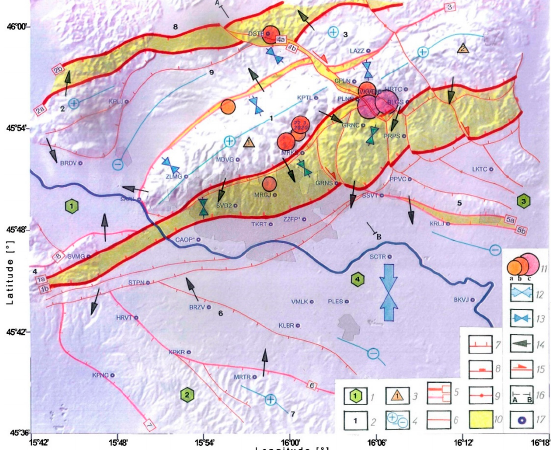
Figure 2. Recent geologic structural framework and seismotectonic activity; 1—Structural units: Žumbera č ka gora ‐ Medvednica (1), Vukomeri č ke gorice ‐ Šamarica (2), Dugo Selo ‐ Vrbovec ‐ Moslava č ka gora (3), Sava River Basin (4); 2—Structures: Medvednica (1), Marija Gorica (2), Hum (3), Plešivica (4), Dugo Selo ‐ Lupoglav (5), Brezovica (6), Vukomeri č ke gorice (7), Krško ‐ Zagorje subbasin (8), Stubica subbasin (9); 3—Structural blocks of Medvednica: Sljeme (1), Zelinska gora (2); 4—Axis of maximum and minimum of gravimetric Bougue anomalies; 5—Most important faults of the structural framework: Zagreb fault (1a,b), Brežice ‐ Koprivnica fault (2a,b), Bistra ‐ Laz fault (3a,b), Stubica ‐ Kašina fault (4a,b), Dugo Selo ‐ Ivani ć Grad ‐ Kutina fault (5a,b), Vukomerice fault (6), Pokupsko fault (7), Sv. Nedjelja ‐ Plešivica fault (8); 6—Larger faults within structures and fault zones and faults following most important faults; 7—Reverse faults; 8—Normal faults; 9—Faults of unambiguous character; 10— Fault zones; 11—Earthquake epicenters with magnitude: (a) 4.6–5.0; (b) 5.1–6.0; (c) 6.1–6.3; 12— Orientation of maximal compressional stress; 13—Orientation of local compressional stress; 14— Direction of movement of structure parts according to geological measurements; 15—Faults with mostly horizontal wing movement; 16—Seismotectonic profile; 17—GPS points of the geodynamic network.